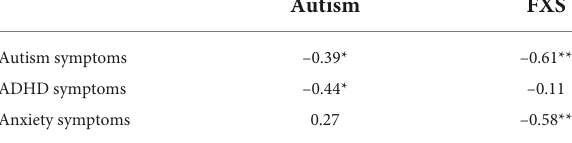
TABLE 3 Correlations between joint attention performance and phenotype control measures. Autism FXS Autism symptoms –0.39* –0.61** –0.44*